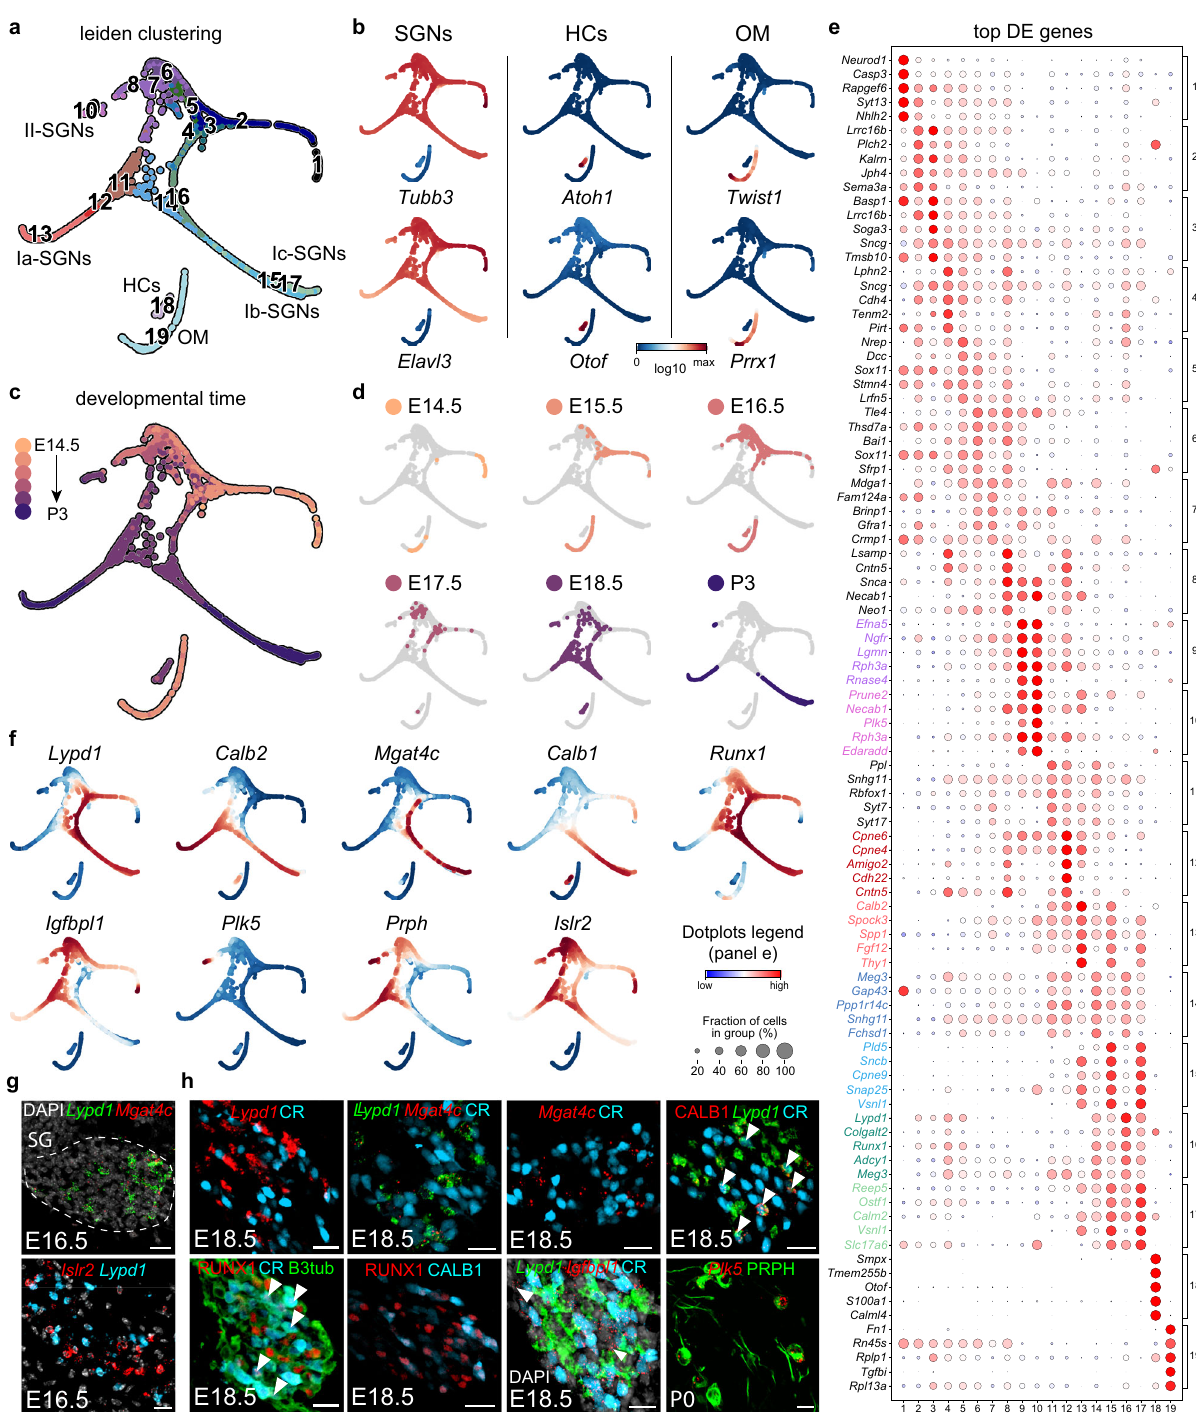
Fig. 1 Developmental diversi fi cation of spiral ganglion neuron lineages. a UMAP visualization of developing SGNs, showing the trajectory from unspecialized SGNs to distinct subtypes from E14.5 to P3 (Cl.1-17). Cl.18 and 19 denote HC and OM cell clusters. b Plots showing expression of marker genes for SGNs, HCs and OM cells. c , d Plots showing the different developmental time points along the trajectory. e Dot-plot of the top 5 most differentially expressed genes (DEGs) for each cluster shown in a . f Plots showing different marker genes delineating different SGN subtype trajectories. g , h In vivo con fi rmation of marker genes from f using immunostaining and RNAscope on SG sections from E16.5 ( g ) or E18.5 and P0 ( h ). At E16.5, Lypd1 and Mgat4c colocalize and label the emerging I c population, while the I a /I b /II lineage is marked by Islr2 expression. At E18.5, RUNX1, Lypd1 and Mgat4c colocalize and label the I c population; SGNs expressing only CR (calretinin) represent the I a population, and SGNs expressing Lypd1 , CR and CALB1 represent the I b population. Type II SGNs are marked by Igfbpl1 and by Plk5 /PRPH expression at E18.5 and P0. Scale bars: 20 µ m. Data in b and f are MAGIC imputed log10(fpm) expression. DE differentially expressed, HC hair cell, OM otic mesenchyme, SGN spiral ganglion